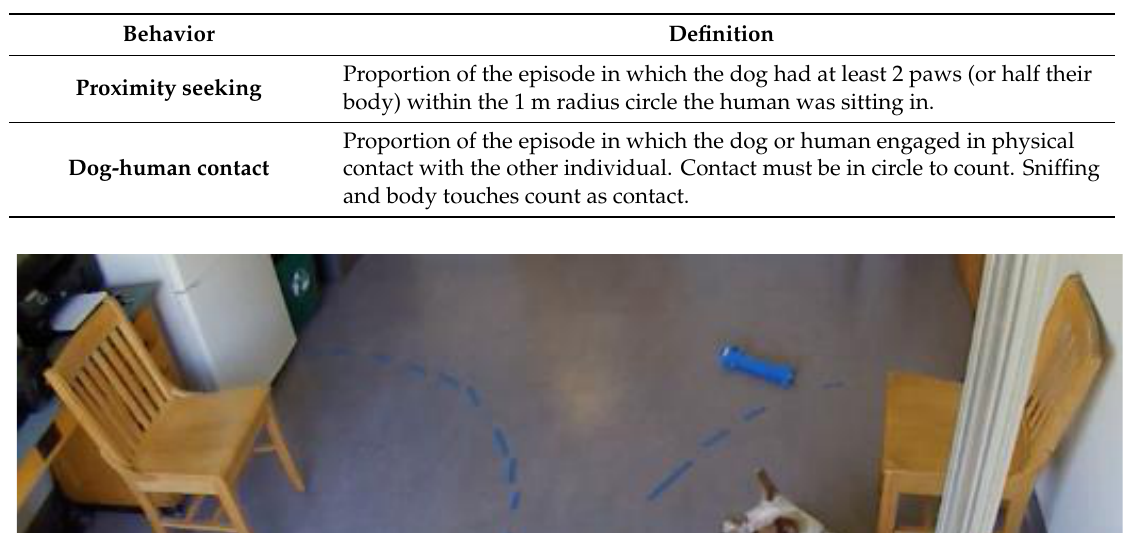
Table 2. Paired Attachment ethogram.